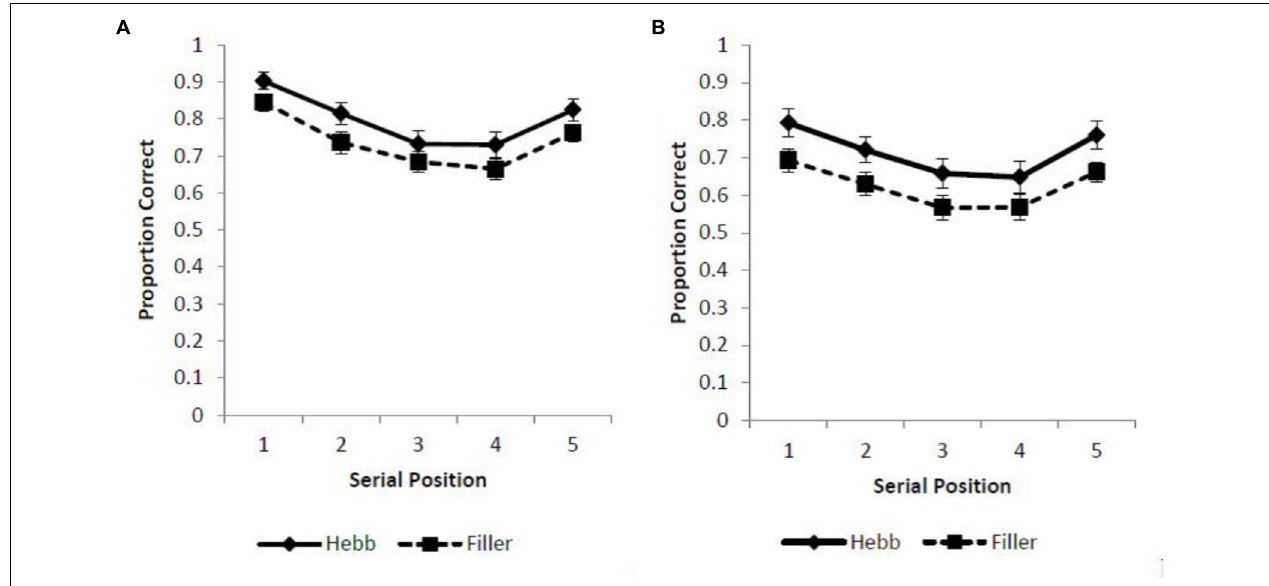
FIGURE 1 | (A,B) Mean proportion correct recall scores for the filler and Hebb sequences of inverted faces as a function of serial position (1–5) under conditions of (A) full-stimulus-overlap and (B) no-stimulus-overlap. Error bars represent the standard error of the